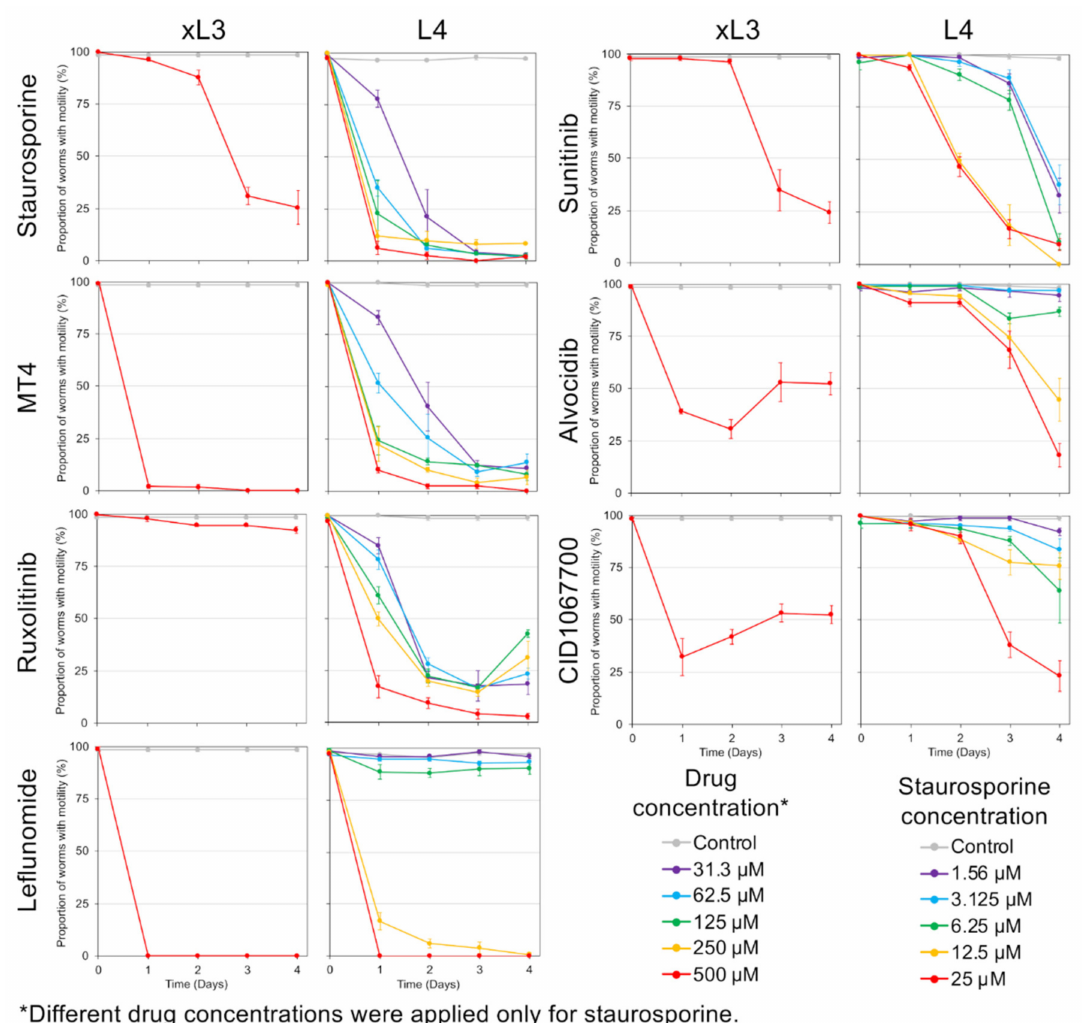
Figure 3. Motility assay results for H. contortus xL3 (single concentration) and L4 (dilution series) nematode intestinal toxins/toxicants (NIT) treatments, including staurosporine (IC 50 of 2.37 µ M, 1 day), MT4 (56.7 µ M, 1 day), ruxolitinib (221.5 µ M, 1 day), leflunomide (L4-stage IC 50 192.9 µ M after 1 day), sunitinib (161.5 µ M, 2 days), alvocidib (427.0 µ M, 3 days), and CID1067700 (215.1 µ M, 4